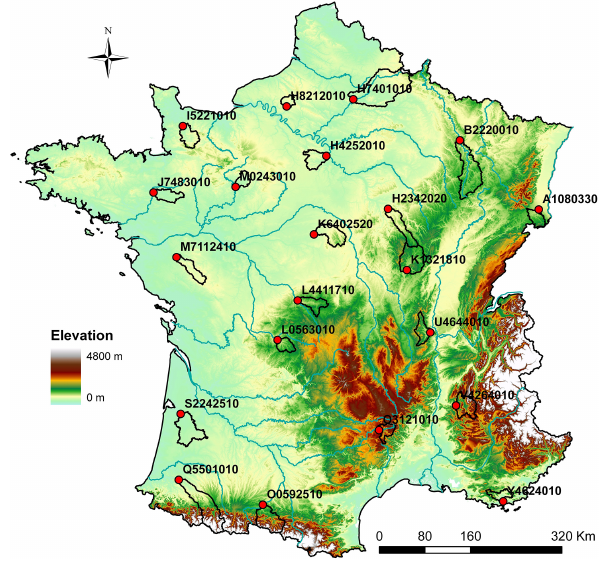
Figure 1. Location of the 21 selected catchments in France. Each outlet is shown by a dot and referred to with the HYDRO code (see details in Table